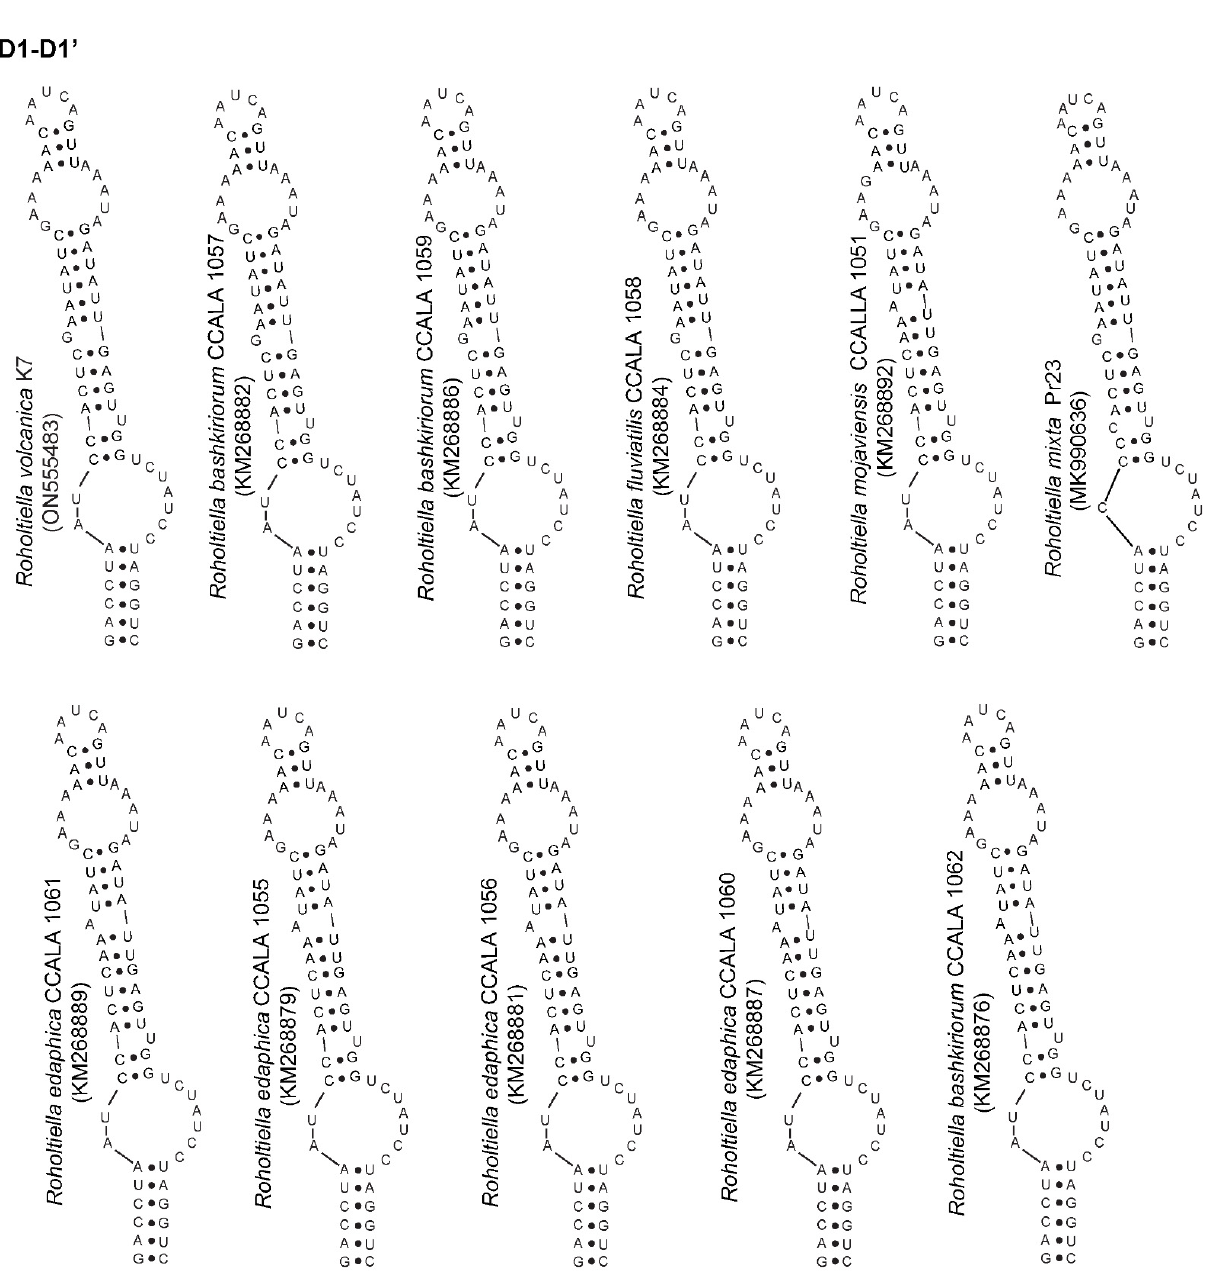
Figure 4. Comparative secondary structure analysis of the D1-D1 ′ helix region of Roholtiella volcanica K7 with the other members of the genus Roholtiella .